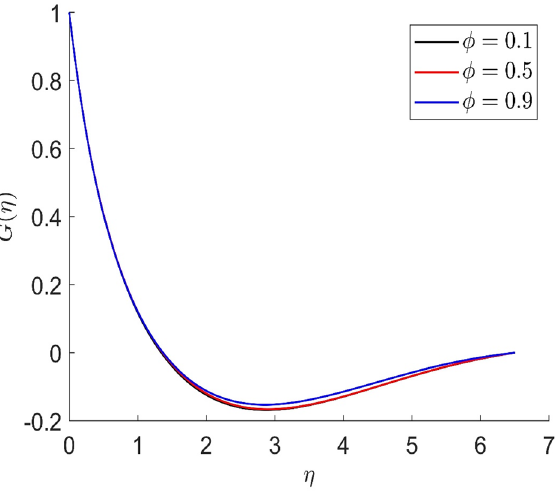
Figure 13. Representation of tangential velocity g (η) for the different values of φ with R = 3, n = 3, v = 0.8, m = 3.5, Pr = 0.7, φ 1 = 0.2, φ 2 = 0.4, β 3 = 0.6, β = 0.4, β 1 = 0.3, β 2 = 0.5, u = 0.4, ξ = 0.4.